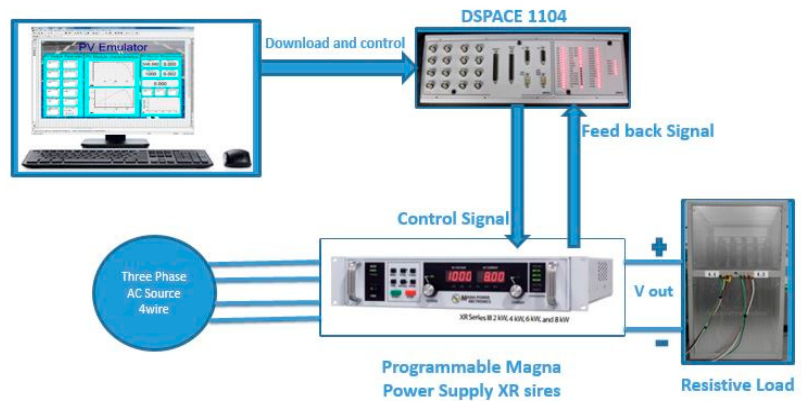
Figure 2. The PV emulator setup in our hardware testbed [23].